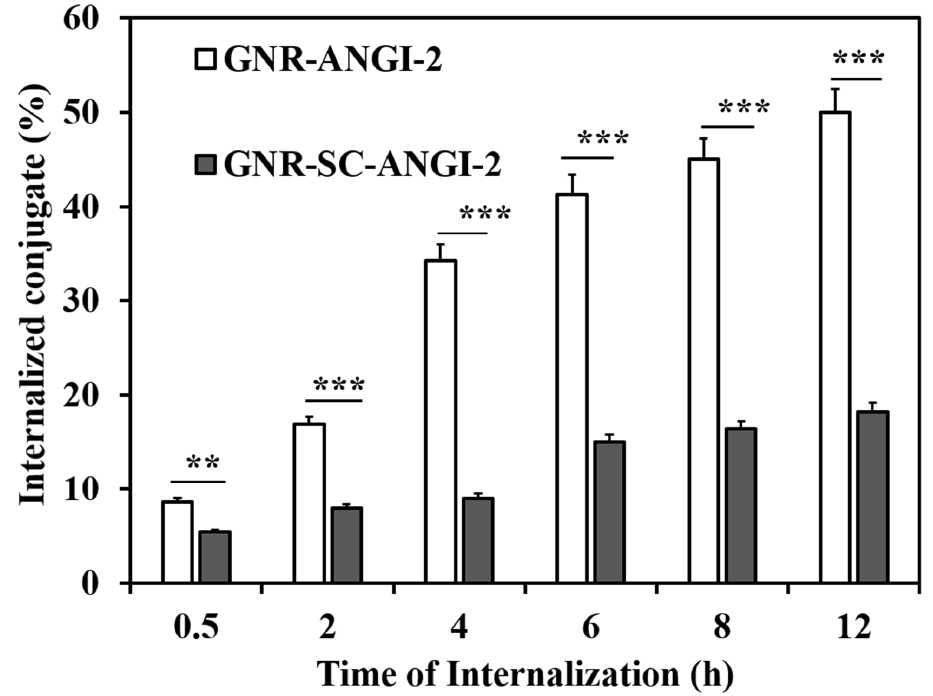
Figure 4. Time-dependent cellular internalization experiment of GNR-ANGI-2 and GNR-SC-ANGI- 2. Following incubation of C6 cells with GNR-ANGI-2 and GNR-SC-ANGI-2 at a concentration